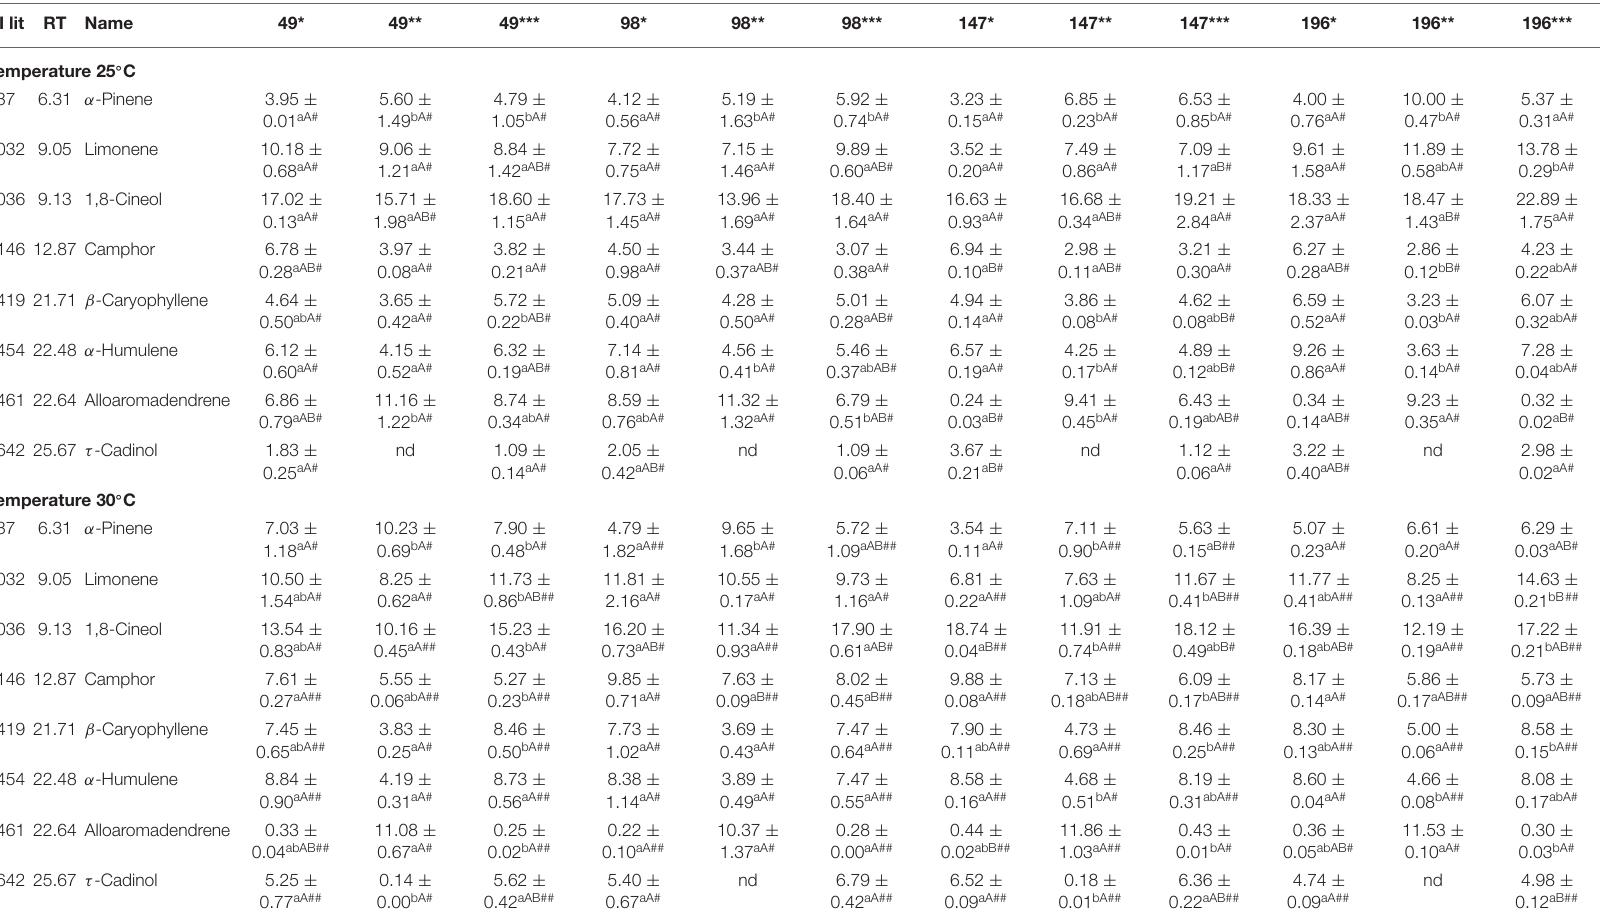
TABLE 3 | The content of VOCs in hexane extracts (area % ± SD) of S. yangii shoots cultured in vitro in different LI and temperature